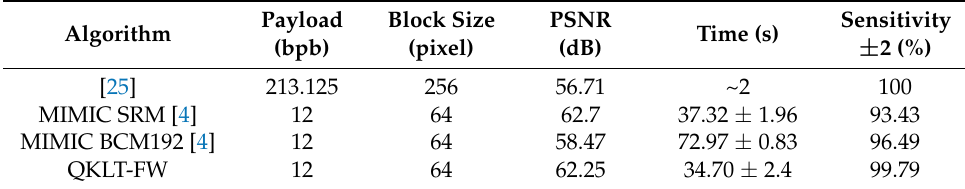
Table 2. Comparison among different embedding